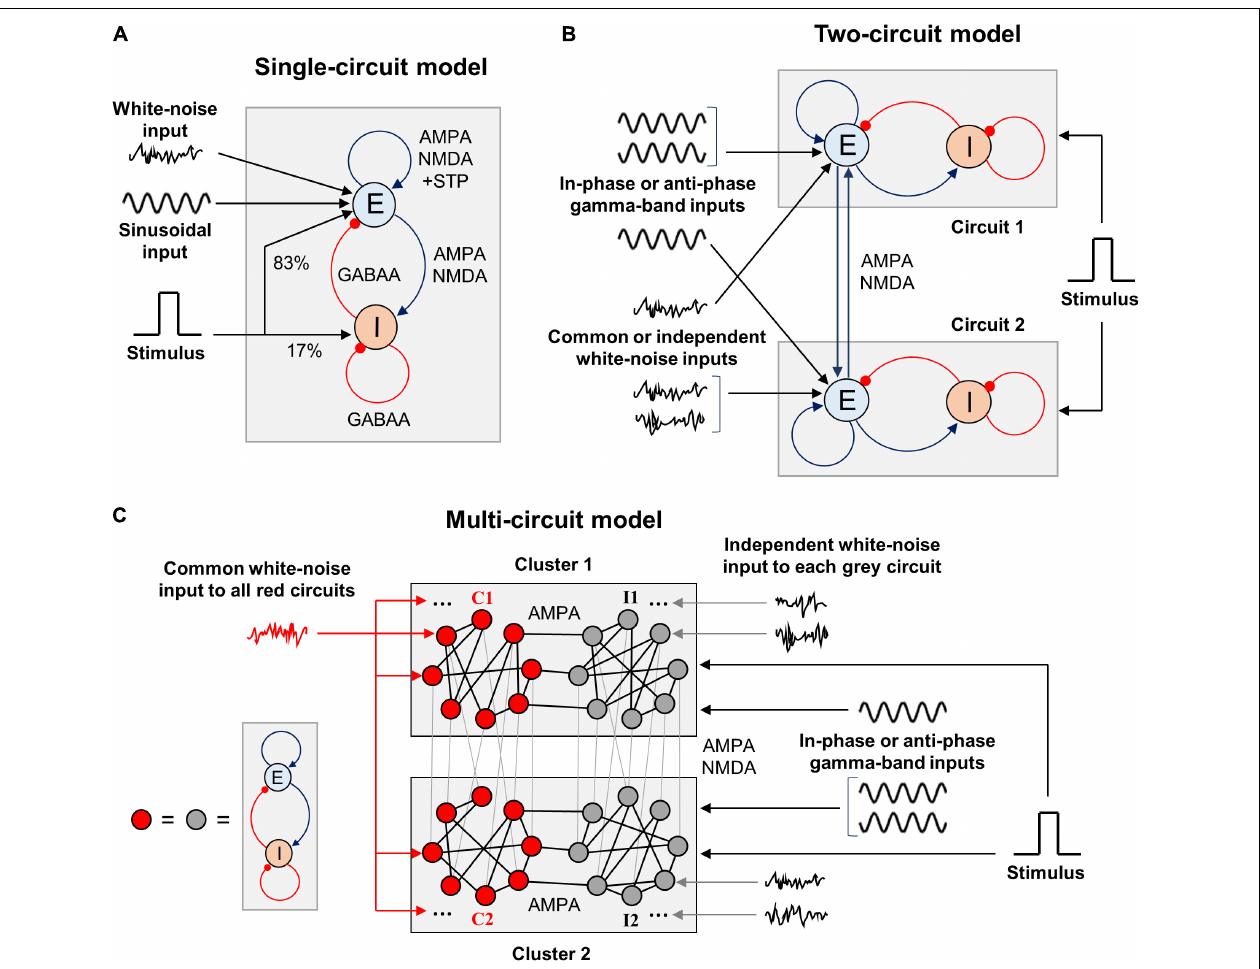
FIGURE 1 | Schematic representation of the WM model types we explore in this study. (A) Single-circuit system. E, excitatory population; I, inhibitory population. The excitation is mediated by AMPA and NMDA receptors, inhibition – by GABAA receptors. The excitatory-to-excitatory connections demonstrate short-term plasticity. White-noise and oscillatory inputs are delivered to the excitatory population. A rectangular stimulus-related signal is delivered to the excitatory and inhibitory populations in the proportion of 5:1. Both populations also receive constant inputs (not shown). (B) Two-circuit system. The circuits are structurally identical to the one shown in (A) and intercoupled via excitatory connections with varying NMDA:AMPA ratio. Gamma-band sinusoidal input is delivered to the excitatory populations of the circuits, either in the same phase or in the anti-phase. White-noise inputs (identical or independently generated) are also delivered to the excitatory populations. The stimulus-related signal is delivered in the same way as in (A) , and it is identical for both circuits. (C) Multi-circuit model. Each circle represents a circuit, structurally identical to the one shown in (A) . The circuits are grouped into two local clusters; each cluster contains two circuit groups. Lines connecting the circles represent symmetrical excitatory inter-circuit connections. Within-cluster inter-circuit connections are mainly AMPA-mediated (NMDA:AMPA ratio is 0.1), inter-cluster connections could be predominantly mediated either by AMPA or NMDA. The circuits from the “red” groups (C1 and C2) receive a common white-noise input; the circuits from the “gray” groups (I1 and I2) receive independent white-noise inputs. All the circuits from each cluster receive gamma-band input in the same phase; the inputs to the clusters could have the same phase or the opposite phases. The same stimulus-related signal is delivered to each